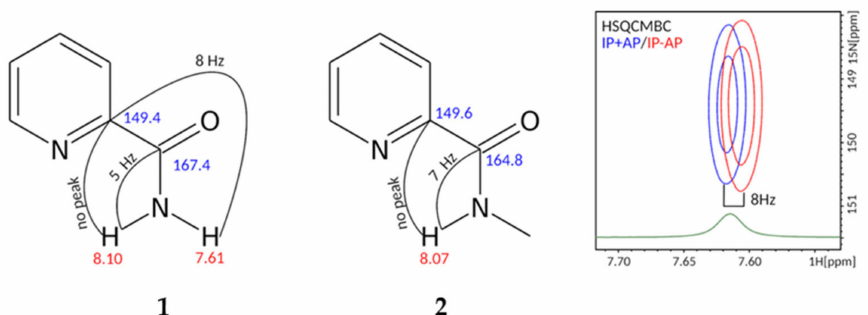
Figure 2. Structures of compounds 1 , 2 are shown with the results of NMR analysis, performed in CDCl 3 at 0 and 10 ◦ C, respectively. Values of measured heteronuclear J -couplings are indicated. The right panel shows the superposition of IP+AP and IP-AP HSQMBC spectra, corresponding to the HN-C-C 3 J -coupling. Fragment of 1 H spectrum is shown in